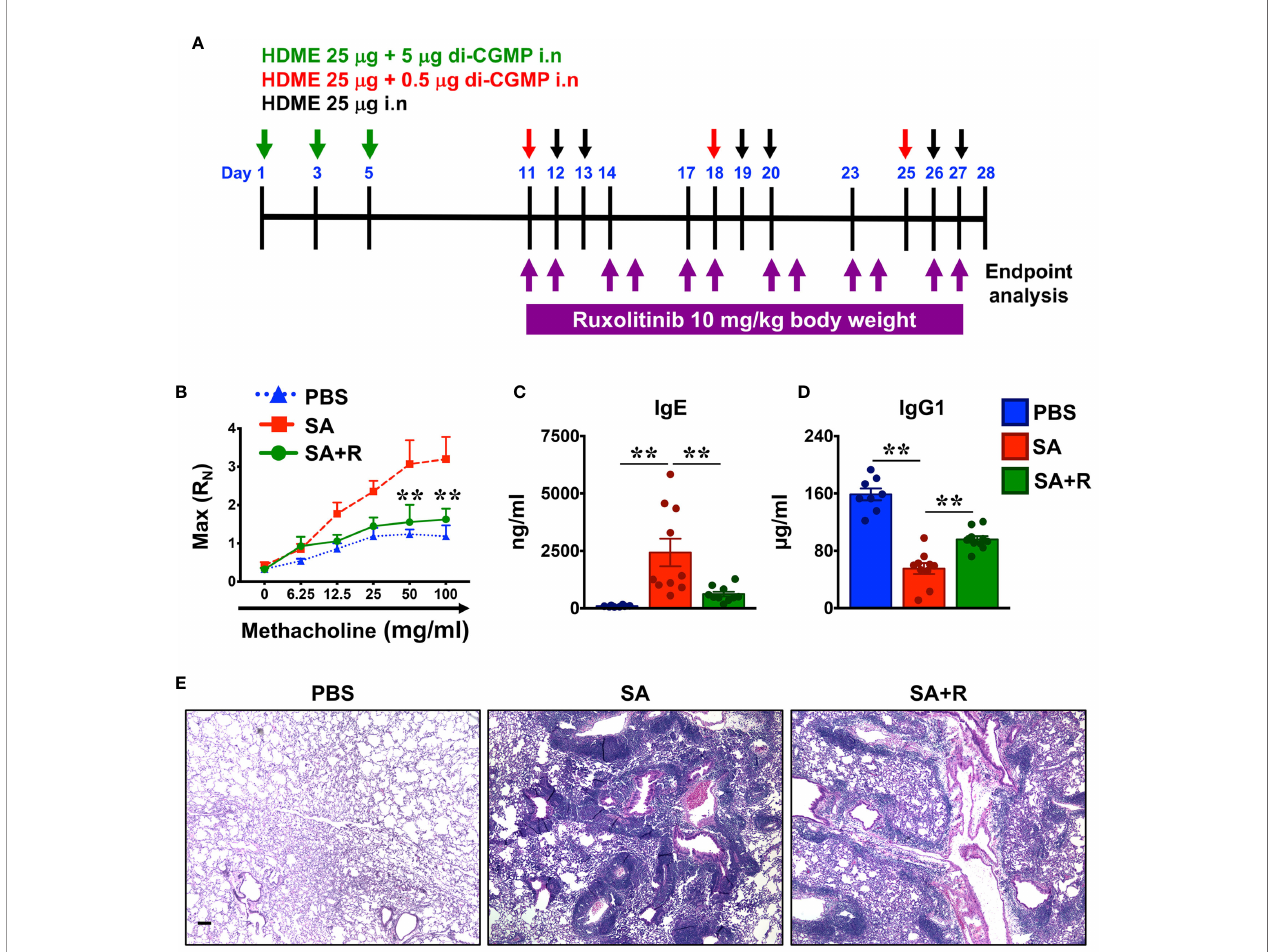
FIGURE 2 | Ruxolitinib ameliorates AHR as well as reduces IgE production and lung in fl ammation in a mouse model of SA. (A) Schematics of the severe asthma (SA) model used in the study. Mice were sensitized with HDME and c-di-GMP (green arrows) and subsequently challenged with HDME and a lower dose of c-di- GMP (red arrows) or HDME alone (black arrors) as indicated. During the challenge phase, mice were also treated intranasally (i.n) with Ruxolitinib (R, 10 mg/kg body weight) for two consecutive days followed by a day of rest for a total of 12 injections. (B) Twenty-four hours after the last injection, mice were analyzed for AHR. Assessment of resistance to air fl ow in central airways (Newtonian resistance [Rn]) after challenge with increasing doses of methacholine (Mch). Data is shown as mean ± SEM and pooled from 3 independent experiments with a total of 9-12 mice per cohort. Statistical signi fi cance was determined by two-way ANOVA. **p ≤ 0.01. (C, D) Levels of serum IgE (C) and IgG1 (D) in PBS-treated, SA (challenged with HMDE+c-di-GMP) or SA mice treated with Ruxolitinib (SA+R). Data is shown as mean ± SEM and pooled from 3 independent experiments with a total of 8-13 mice in each group. Statistical signi fi cance was determined by Student ’ s unpaired t test with Welch ’ s correction. **p ≤ 0.01. (E) Hematoxylin and eosin (H&E) staining of lung section of PBS-treated, SA and SA+R mice. Scale bar: 100 m m. Representative micrographs of the lung sections at 4X magni fi cation. Data is representative of 3 independent experiments with a total of 9 mice per